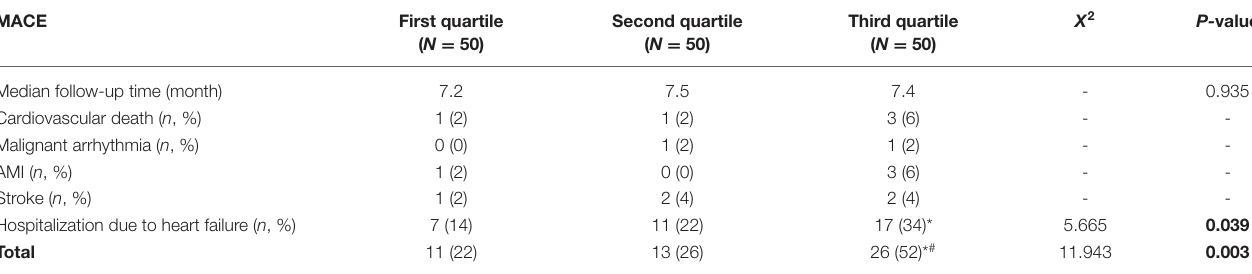
TABLE 7 | Comparison of short-term ( < 1 year) prognosis of HFpEF patients of different liver hardness groups. MACE First quartile